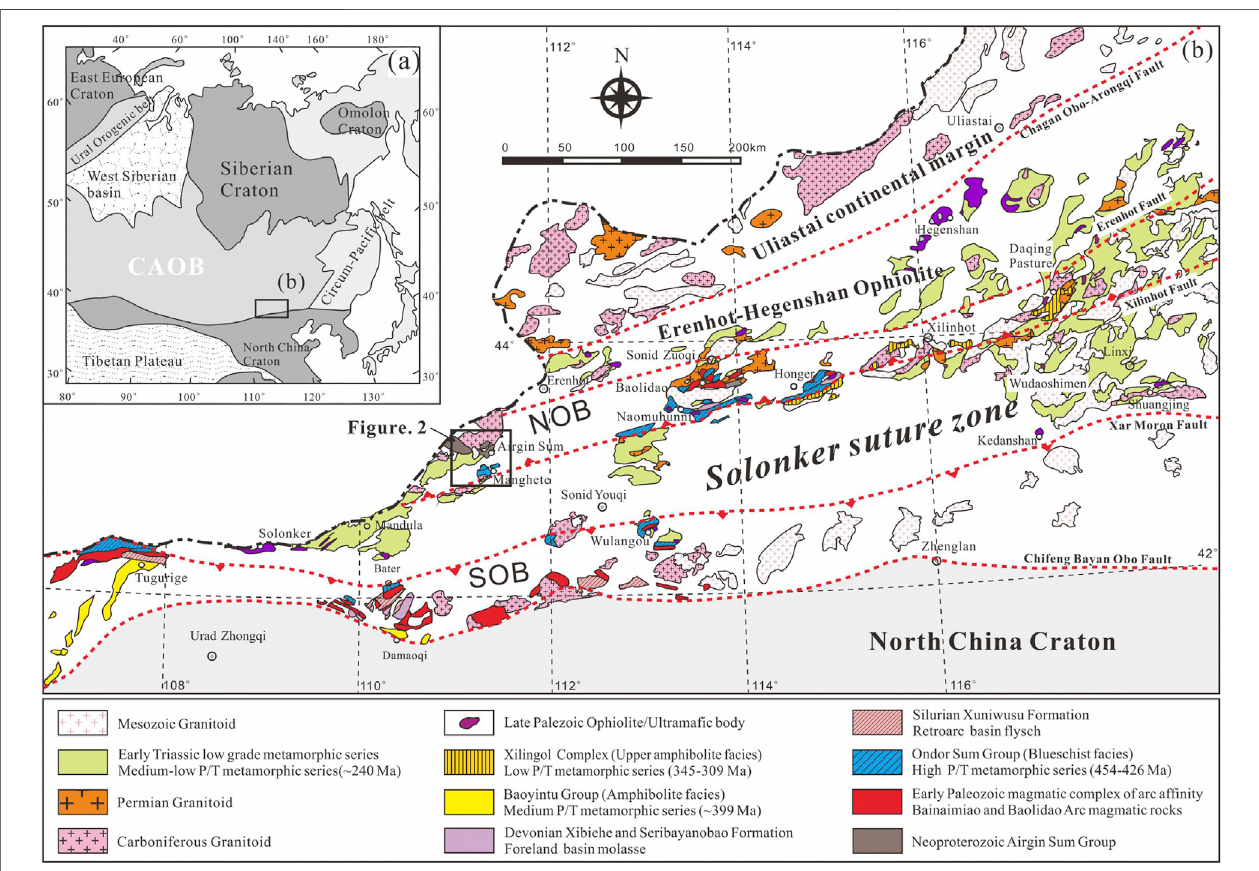
FIGURE 1 | (A) Location of the Central Asian Orogenic Belt (modi fi ed after Xu et al., 2013). (B) Geological sketch map of the central Inner Mongolia showing the subdivided tectonic units (compiled from IMBGMR, 1991; Jian et al., 2008; Xiao et al., 2003; Xu et al., 2013), and distribution of the Ondor Sum Group.